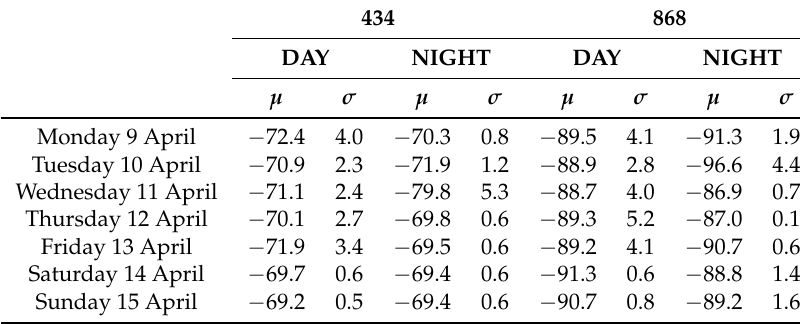
Table 1. Statistics describing the second week of indoor power measurements gathered at RX1.